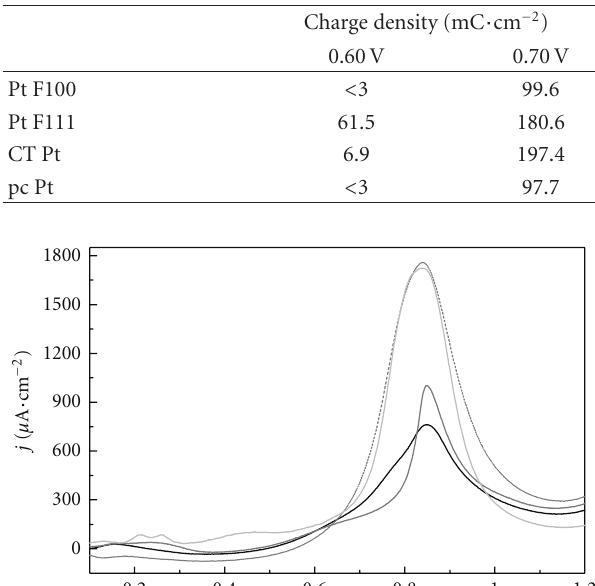
Table 3: Integrated charge densities found under the current transients for methanol electrooxidation after 10min. in oxygen- free 0.1M methanol + 1M sulphuric media on the studied platinum surfaces.